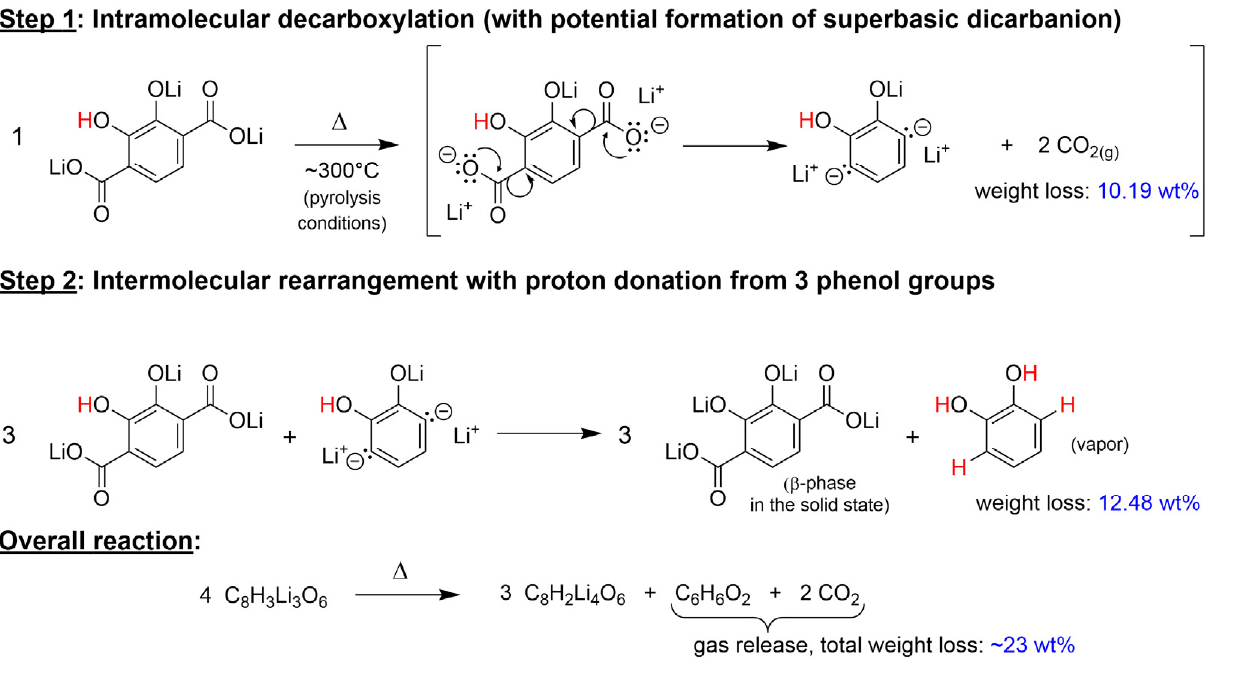
Scheme 2. Proposed thermal concerted retro-Kolbe–Schmitt reaction involving (Li 2 )(Li,H)- o -DHT by controlled pyrolysis reaction to produce Li 4 - o -DHT ( β -phase). The by-products, catechol and car- bon dioxide, are released in the gas phase. Note that heterolytic cleavage of bonds have been con- sidered for the proposed mechanism without direct